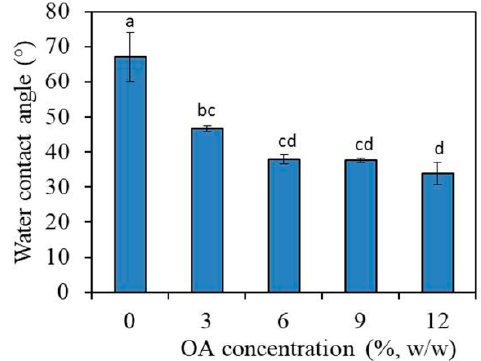
Figure 2. Water contact angle on the surface of composites with 0%, 3%, 6%, 9%, and 12% oleic acid. Bars indicate the mean values of water contact angles and vertical lines standard deviations (SD).